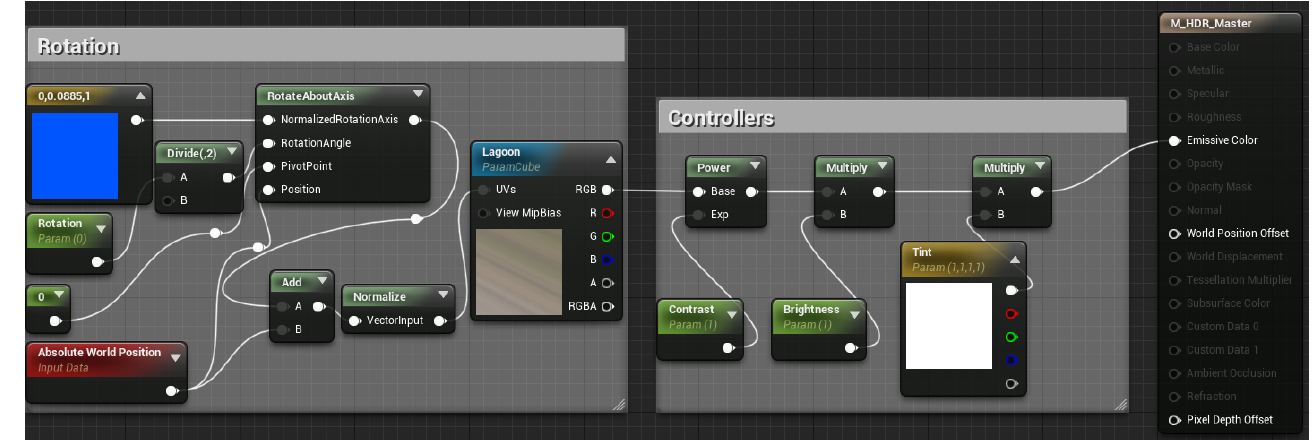
Figure 6. Creating dynamic HDRI settings for the sky sphere with a